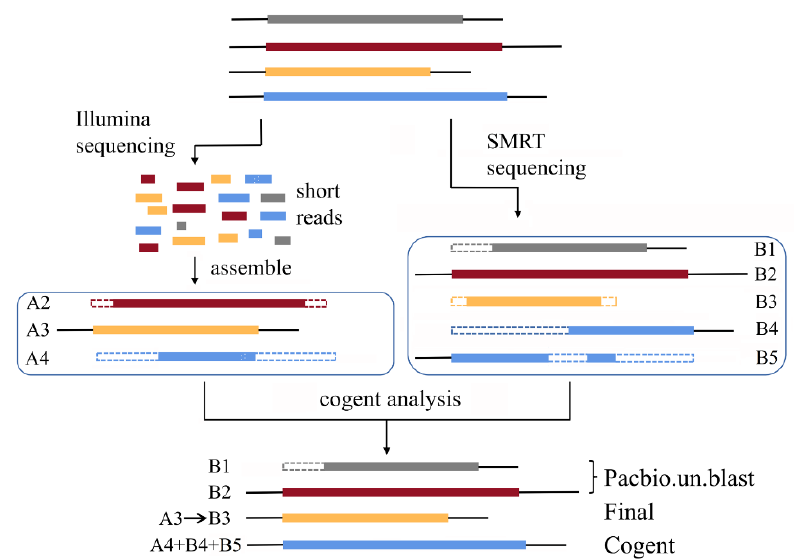
Figure 2. A scheme for cogent analysis of SMRT and Illumina sequencing data. Assembled Illumina sequencing data (group A ) were compared with non-redundant transcripts coming from SMRT sequencing data (group B ), and pairwise distances of transcripts were calculated. Based on the k-mer values, similar transcripts were clustered into the same family, and similar transcripts were reconstructed into one new transcript by using a De Bruijn graph method. In the De Bruijn graph, Cogent analysis was carried out based on the coverage and identity of the overlap. For example, An from group A and Bm from group B were clustered into the same family. If the identity <95%, return Bm (category one) and, if the coverage >95%, the identity >95%, and the length of An < Bm, return Bm (category two). Category one and category two were merged and named Pacbio.un.blast. If the coverage >95%, the identity >95%, and the length of An > Bm, the sequence of An was assigned to Bm (category three, named Final); if the coverage <95% and the identity >95%, the sequence of An and Bm were reconstructed into one new transcript (category four, named Cogent).